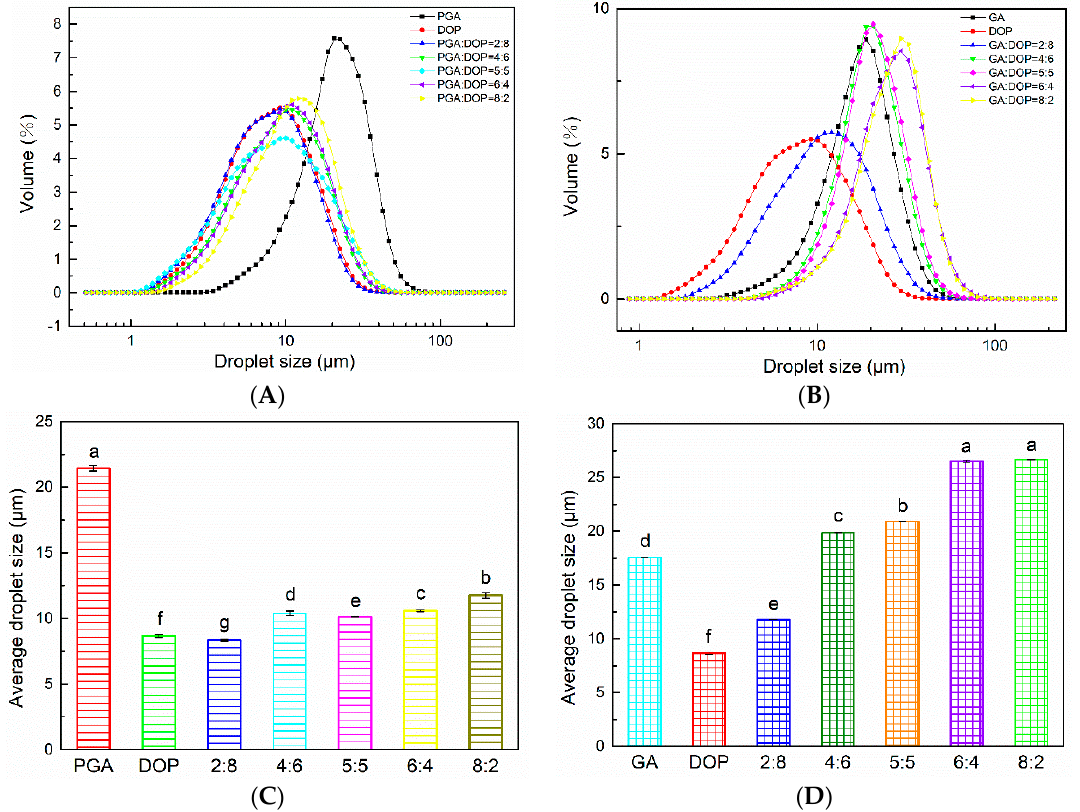
Figure 3. ( A ) Particle size distribution of emulsions prepared by compounding polysaccharides of PGA and DOP as emulsifiers (total emulsifier concentration was 1 wt%); ( B ) Particle size distribution